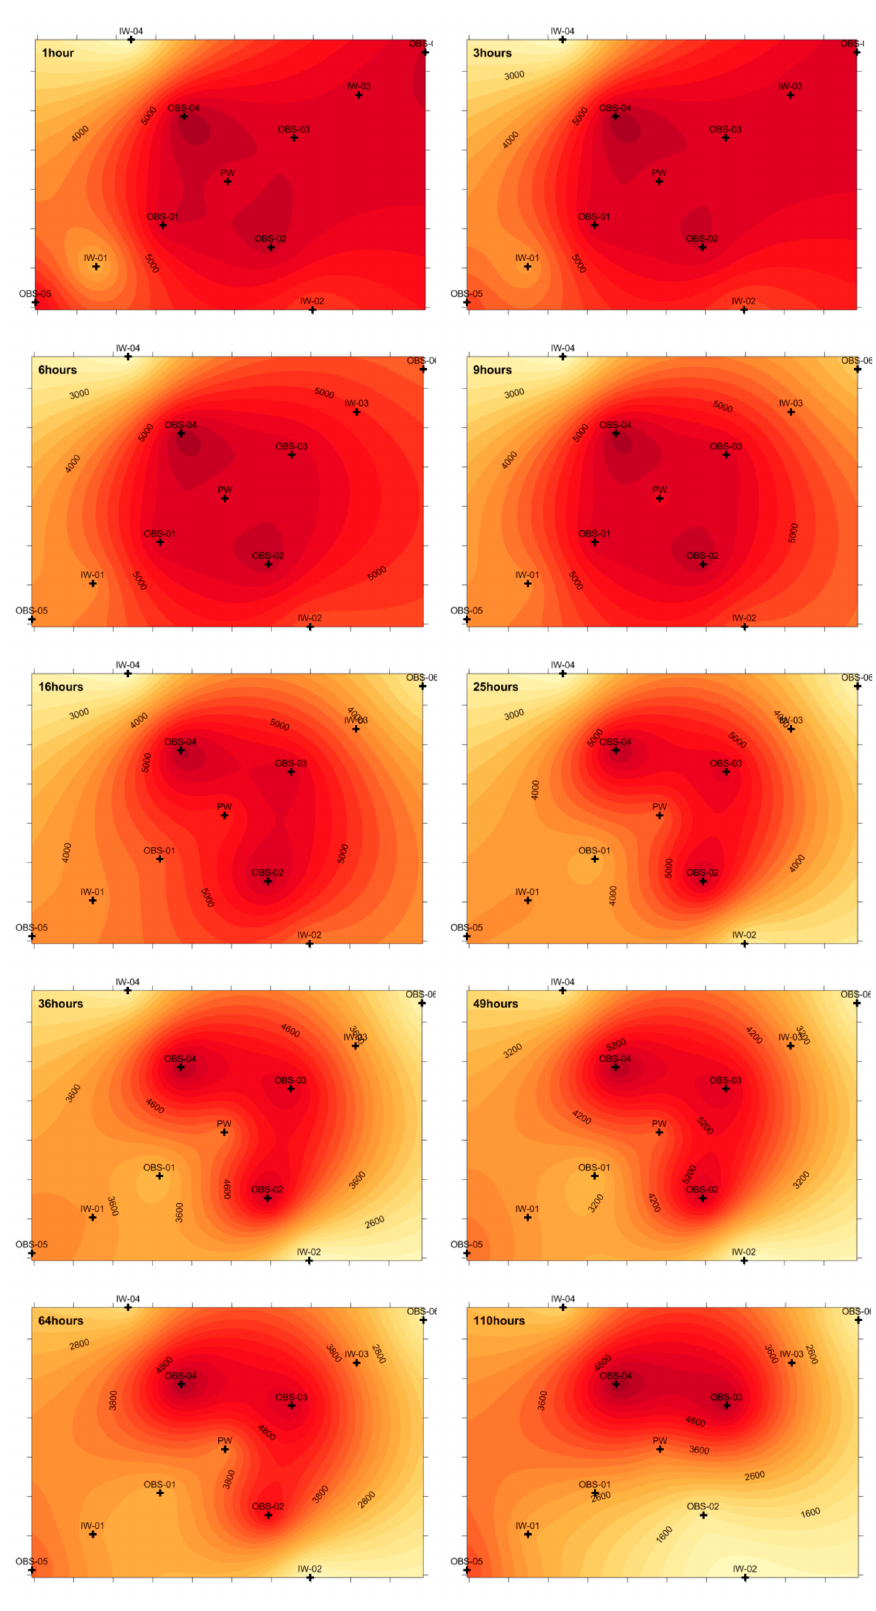
Figure 11. Areal EC values at 25-m depth with elapsed times during the pumping